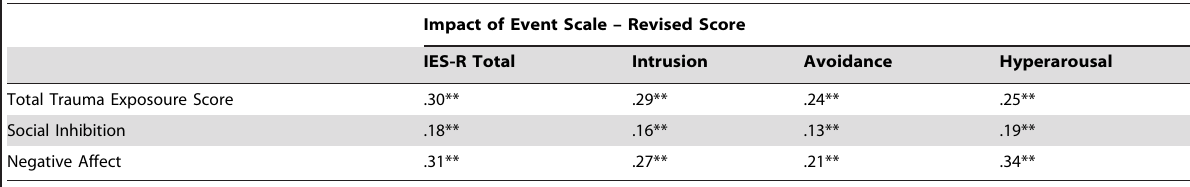
Table 5. Correlations among the